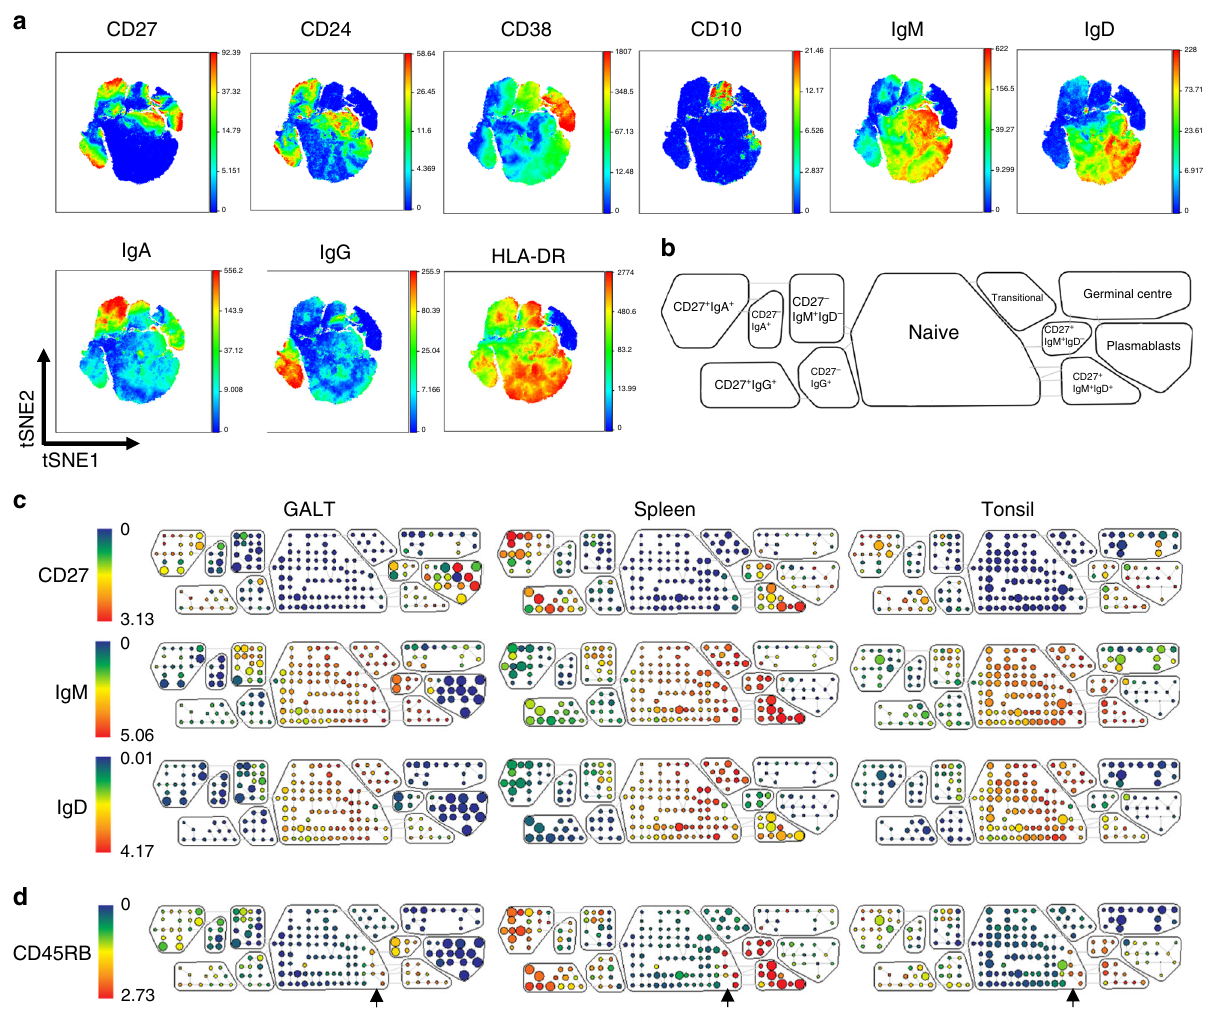
Fig. 1 Deep immunophenotypic pro fi ling of B cells in human tissues. a viSNE projections of the B cell compartment in tissues (GALT n = 8; tonsil n = 5, spleen n = 6). Data were clustered according to criteria used to de fi ne known B cell subsets: CD27, CD24, CD28, CD10, IgM, IgD, IgA, IgG and HLA-DR. b Key to B cells subsets identi fi ed in the SPADE plots in c that were created for each tissue to enable comparisons of their compositions. Expression of CD27, IgM and IgD are illustrated. d Visualisation of the expression of CD45RB in B cell subsets when CD45RB was not one of the clustering criteria. Arrows identify the location of CD45RB + cells in the naïve B cell SPADE